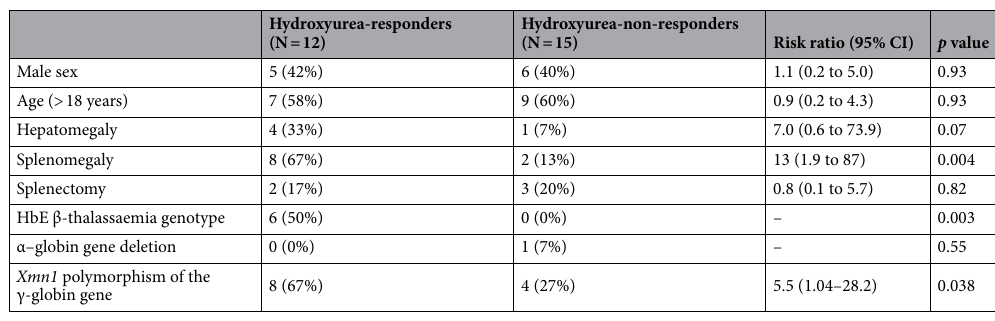
Table 6. Distribution of genetic modifiers among hydroxyurea-responders and non-responders. Data are n